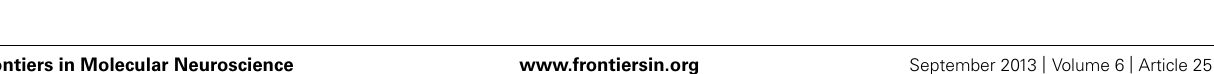
Frontiers in Molecular